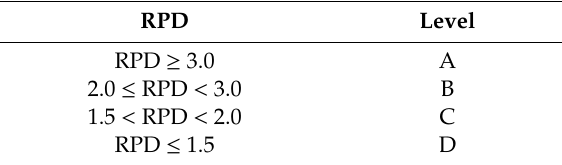
Table 2. The ratio of performance of deviation (RPD)